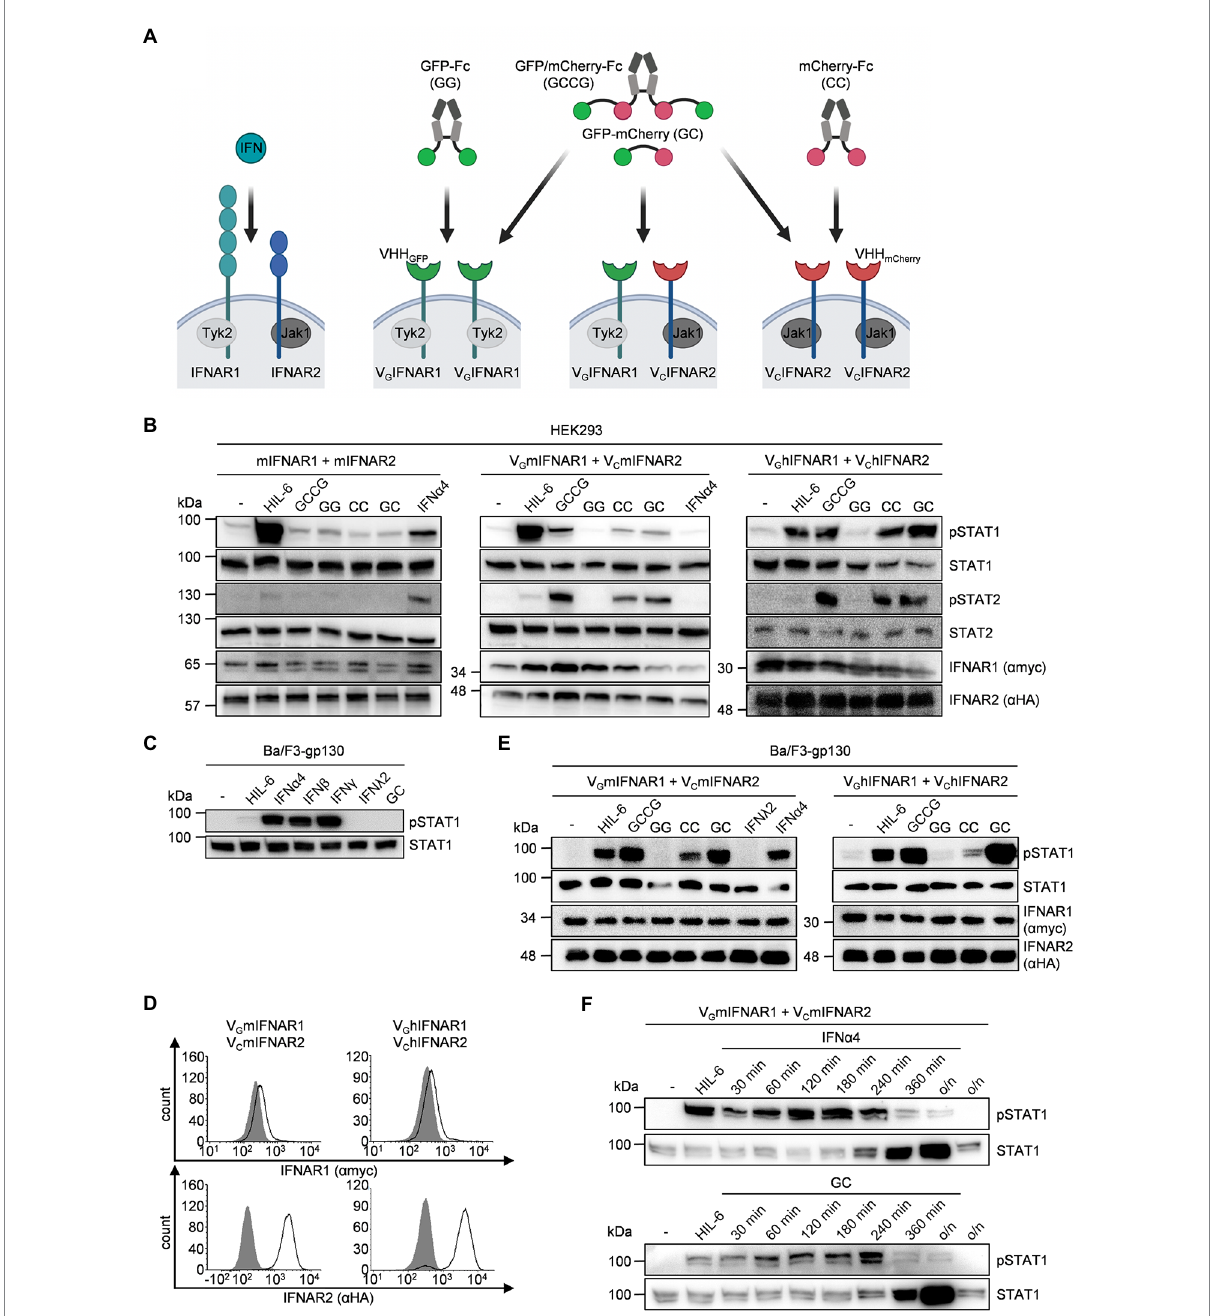
FIGURE 2 Comparable pattern and intensities of STAT activation by native and synthetic type I IFN receptors. (A) Whereas native type I IFN signaling depends on IFNAR1/2 heterodimers, the synthetic cytokines can engage different IFNAR1/2 receptor combinations. IFNAR1 (myc-tagged, lagoon) and IFNAR2 (HA-tagged, blue) which are associated with Tyk2 and Jak1, respectively. In the synthetic receptors, the extracellular domains of IFNAR1 and IFNAR2 were replaced by nanobodies directed against GFP (green) and mCherry (red), respectively. Native IFNARs are activated by type I IFNs, synthetic IFNARs were activated by multimeric GFP/mCherry ligands (GC, GG, CC, GCCG). (B) STAT1 and STAT2 activation in HEK293 cells transiently expressing murine IFNAR1 and IFNAR2 (left), murine V G IFNAR1 and V C IFNAR2 (middle) or human V G IFNAR1 and V C IFNAR2 (right) treated with 1,000 U/ml IFN α 4, 10 ng/ml Hyper-IL-6 or 100 ng/ml of the synthetic cytokine ligands (GCCG, GG, CC, GC) for 30 min. Equal amounts of proteins (50 μ g/lane) were analyzed via specific antibodies detecting phospho-STAT1, phospho-STAT2 and STAT1, STAT2, IFNAR1 (myc-tagged), and IFNAR2 (HA-tagged). Western blot data shows one representative experiment out of three. (C) STAT1 activation in Ba/F3-gp130 cells after stimulation with 200 U/ml IFN α 4, 100 ng/ml IFN β , 20 ng/ml IFN γ , 20 ng/ml IFN λ 2, 10 ng/ml Hyper-IL-6, or 100 ng/ml of the synthetic cytokine ligands GC for 30 min. Equal amounts of proteins (50 μ g/lane) were analyzed via specific antibodies detecting phospho-STAT1 and STAT1. Western blot data shows one representative experiment out of three. (D) Cell surface expression of Ba/F3-gp130 cells transfected with either murine or human V G IFNAR1 and V C IFNAR2. Expression was detected via antibodies detecting myc-tagged IFNAR1 (upper panel) or HA-tagged IFNAR2 (lower